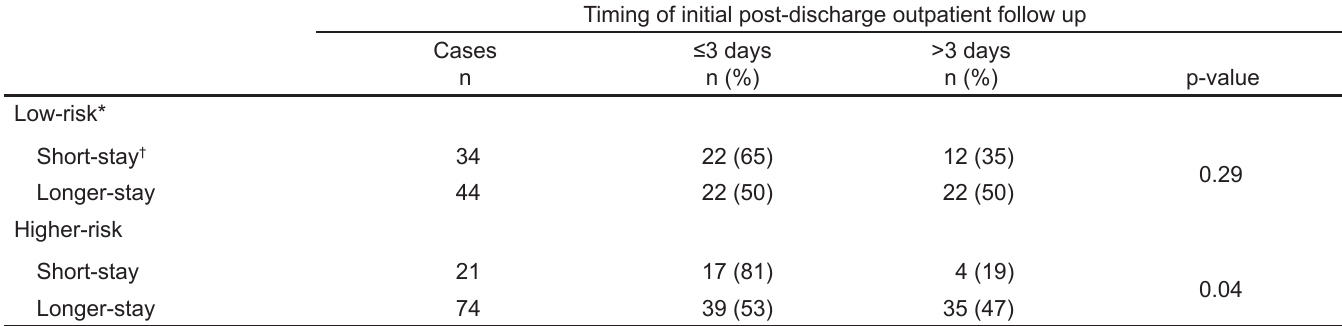
Table 2. Timing of initial post-discharge follow up stratified by risk class and length of stay for emergency department patients with acute pulmonary embolism